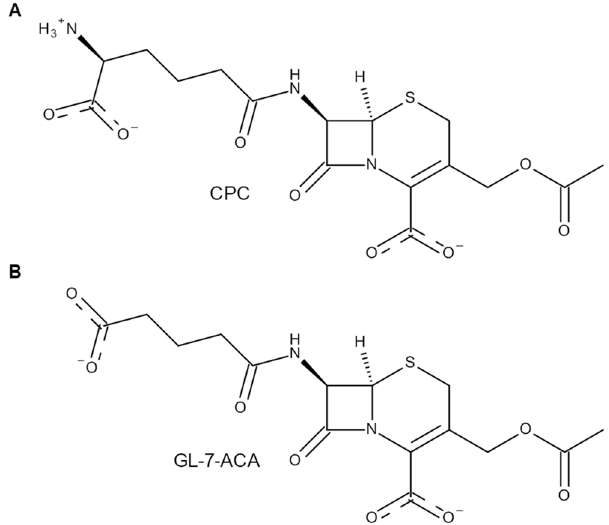
Figure 1. Structures of cephalosporin C (CPC) ( A ) and glutaryl-7-amino cephalosporanic acid (GL-7-ACA) ( B